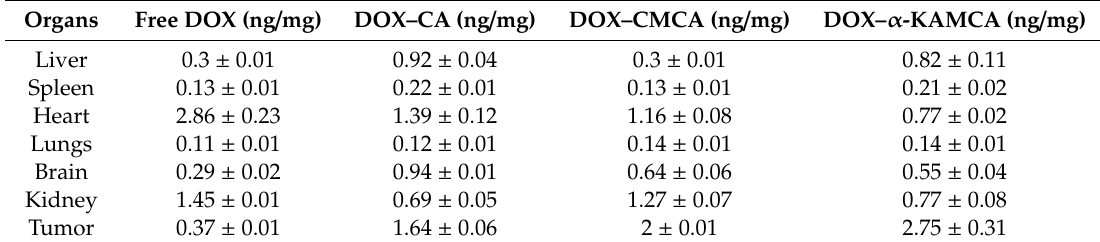
Table 2. Organ distribution of free DOX, DOX-loaded CA NPs, DOX-loaded CMCA NPs, and DOX-loaded α -KAMCA NPs at 2 h of treatment ( n = 5).